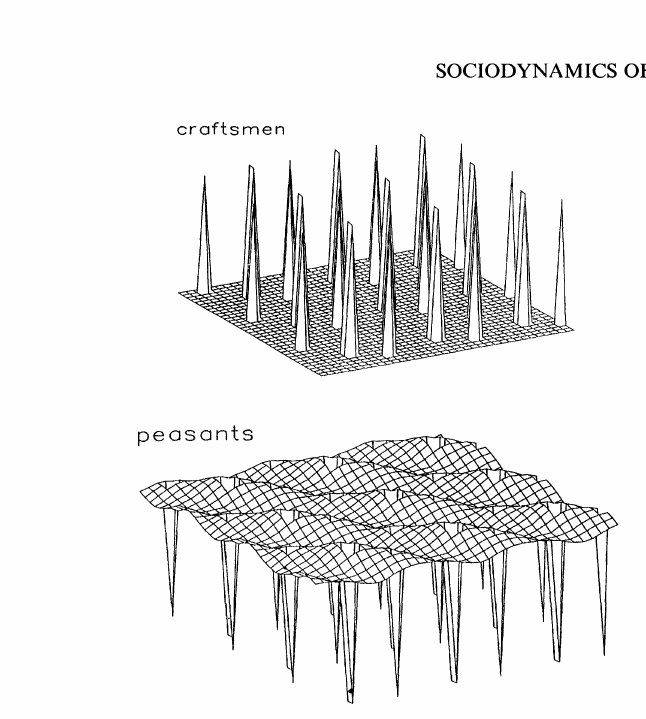
FIGURE 4 Parameters: inclusion of fixed costs (p > 0) and of transportation costs (a > 0). (a) Stationary formation of more than one "town" per unit area in spatial neighbourhood, settled by "craftsmen". (b) Stationary ring-shaped rural settle- ments of "peasants" around the "towns".